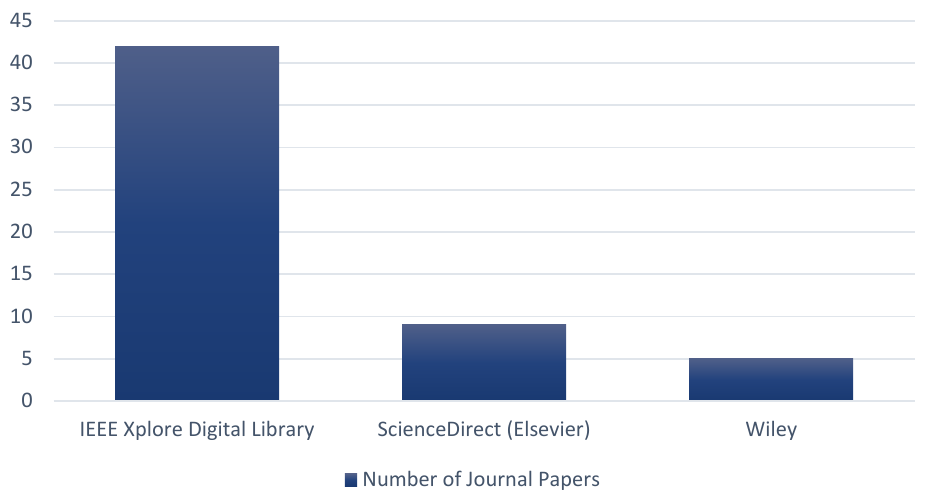
Figure 1. Article Sources and Number of Articles Found.